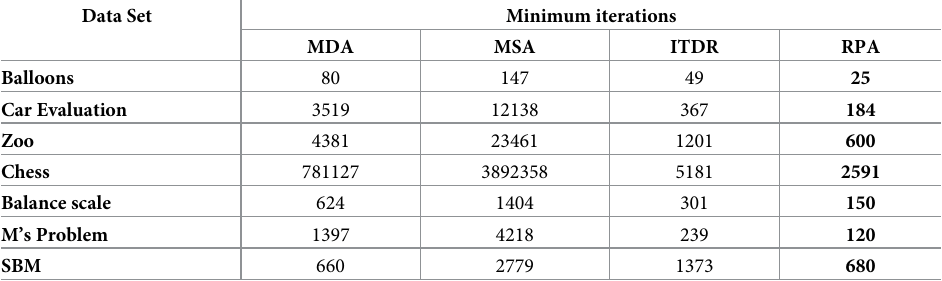
Table 12. Iterative complexity of all techniques.